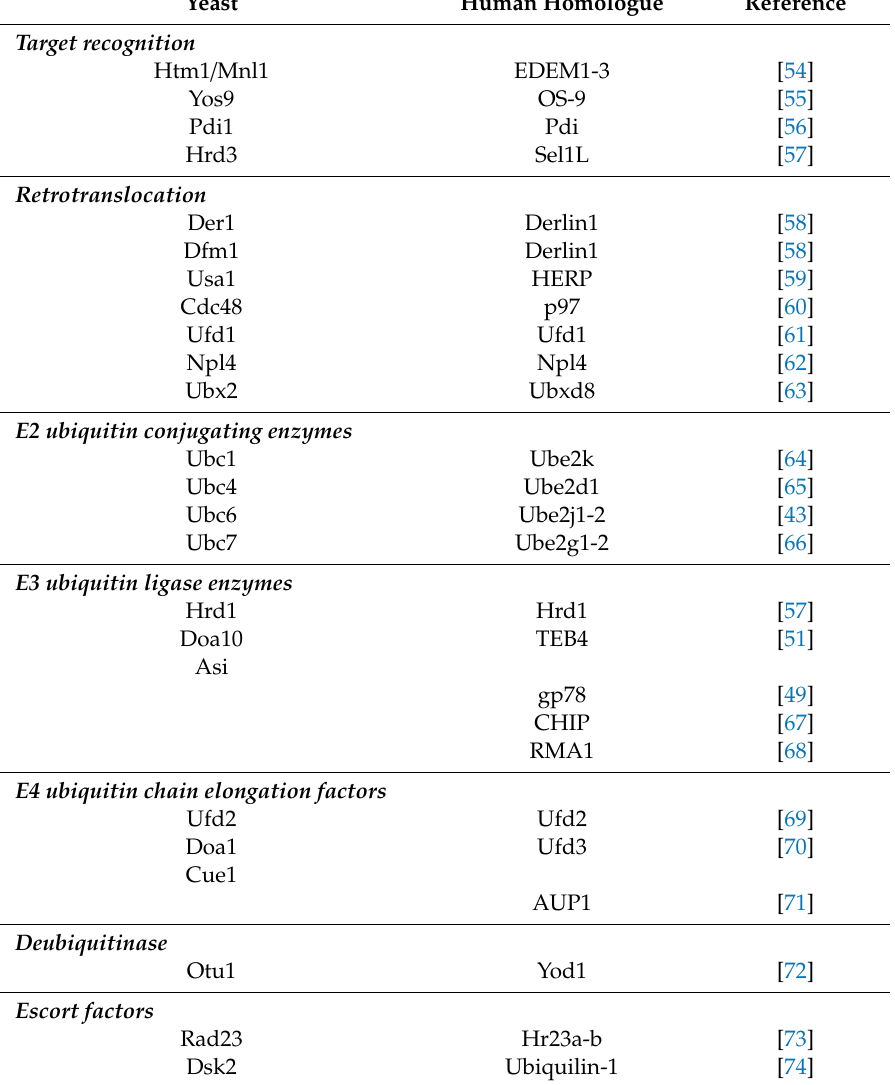
Table 1. Comparison of ERAD components from yeast and mammalian